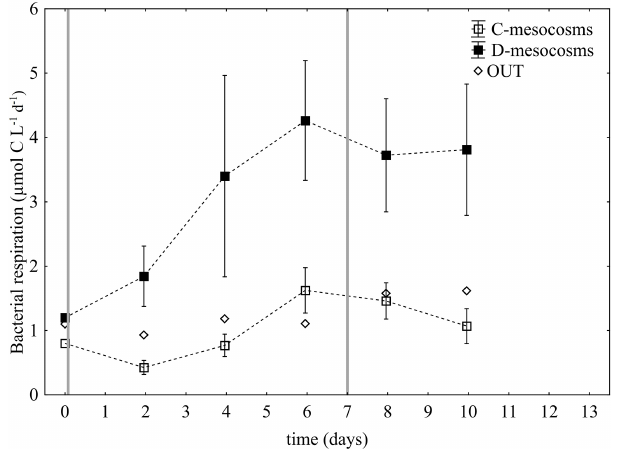
Figure 3. Bacterial respiration (µmol CL − 1 d − 1 , mean ± standard deviation of three replicate mesocosms) in D- and C-mesocosms and OUT samples at 5m depth during the DUNE-R experiment. Grey vertical bars represent the dust seedings.